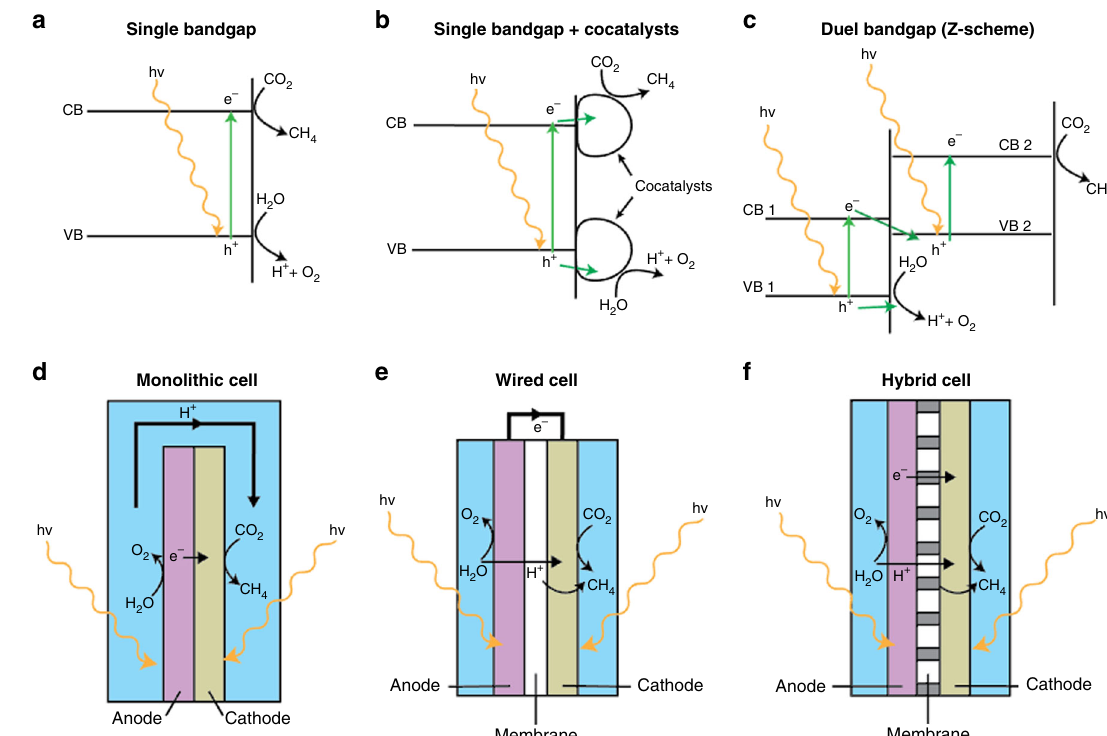
Fig. 6 Band energy diagrams and device architectures of proposed heterogeneous photoredox methanation systems. a A single semiconductor photocatalyst that drives both the water oxidation and CO 2 reduction reactions at its valence (VB) and conduction band (CB) sites. b A semiconductor photocatalyst with co-catalysts added to facilitate reduction and oxidation half-reactions. Electrons and holes can be transferred to the co-catalysts to initiate the associated half-reactions. c A Z-scheme consisting of two semiconductor photocatalysts, in which the water oxidation reaction is occurring at VB 1, and the CO 2 reduction reaction occurs at CB 2. Electron transfer between the two semiconductors can be facilitated through the appropriate choice of semiconductors. Photoelectrochemical device architectures of ( d ) a monolithic device, in which protons and electrons are transferred from the anode to the cathode through an electrolyte or via conduction, respectively; ( e ) a wired device, in which protons and electrons are transferred from anode to cathode via a membrane and an external circuit, respectively; and ( f ) a photoelectrochemical cell, in which the anode and cathode are separated by a proton-